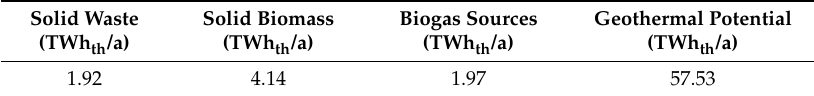
Table 3. Estimation of biomass potentials and geothermal energy potential for Saudi Arabia from 2015–2050.